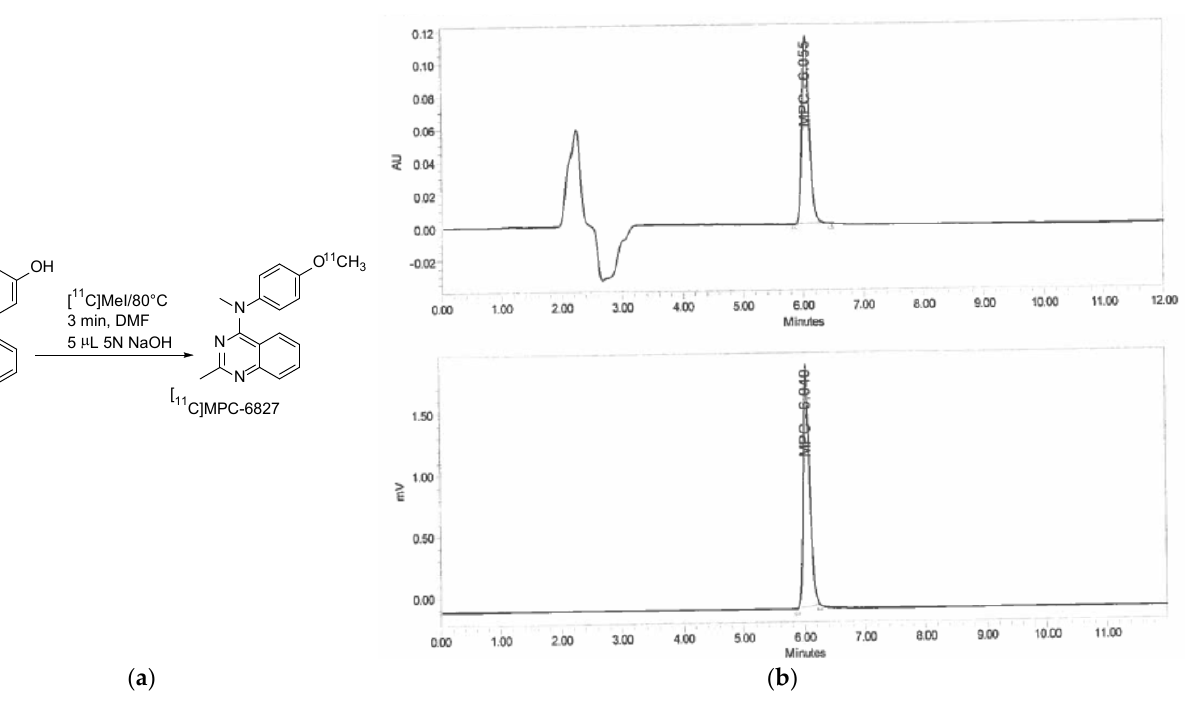
Figure 1. ( a ) Radiochemical scheme of [ 11 C]MPC-6827 production; ( b ) associated QC -HPLC of a co- injection with MPC- 6827, QC conditions: Isocratic HPLC with 40% acetonitrile and 60% 0.1 M aque- ous ammonium formate solution (pH 6.0– 6.5) at a UV wavelength of 254 nm and a flow rate of 1.0 mL/min [reverse -phase Prodigy ODS-3 (250 × 4.6 mm, 5 µm)]. Mouse brain sections were used for performing saturation-binding assay. Co-incu- bation with non- radioactive MPC -6827 (200 µM) reduced the total binding signal signifi- cantly (>70%). A linear increase in nonspecific binding was observed with tracer concen- tration. Saturation of total binding was observed at radiopharmaceutical concentrations above 20 nM. The K d value for [ 11 C]MPC-6827 is determined as 10.03 nM through autora-